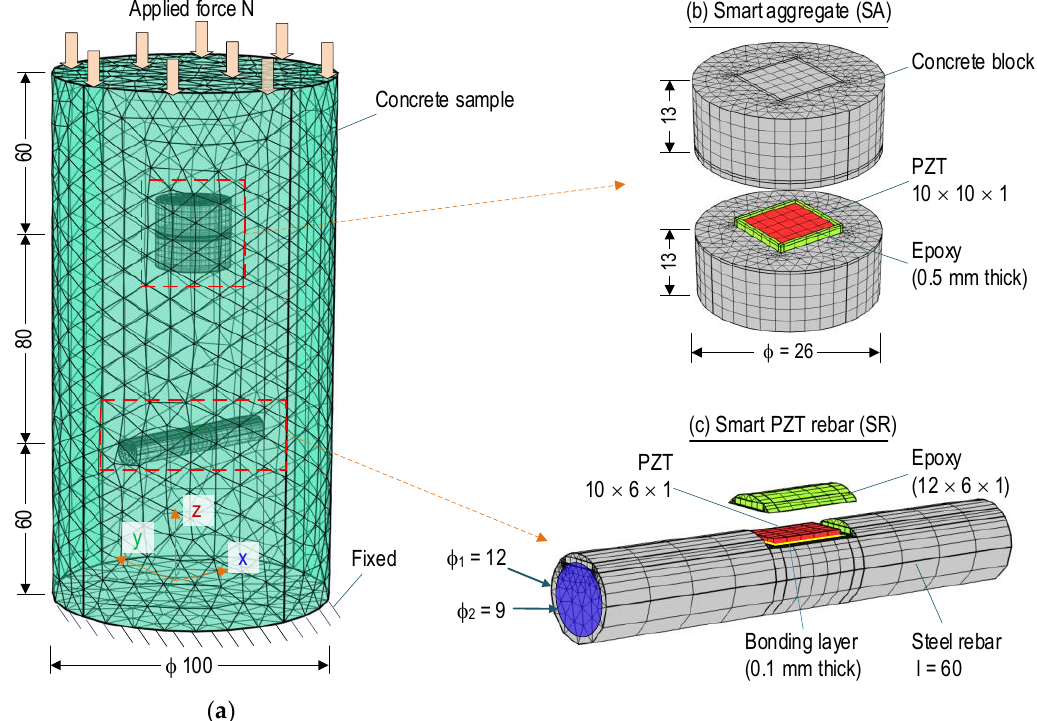
Figure 8. Impedance signatures of coated PZT sensor, smart rebar, and smart-aggregate.